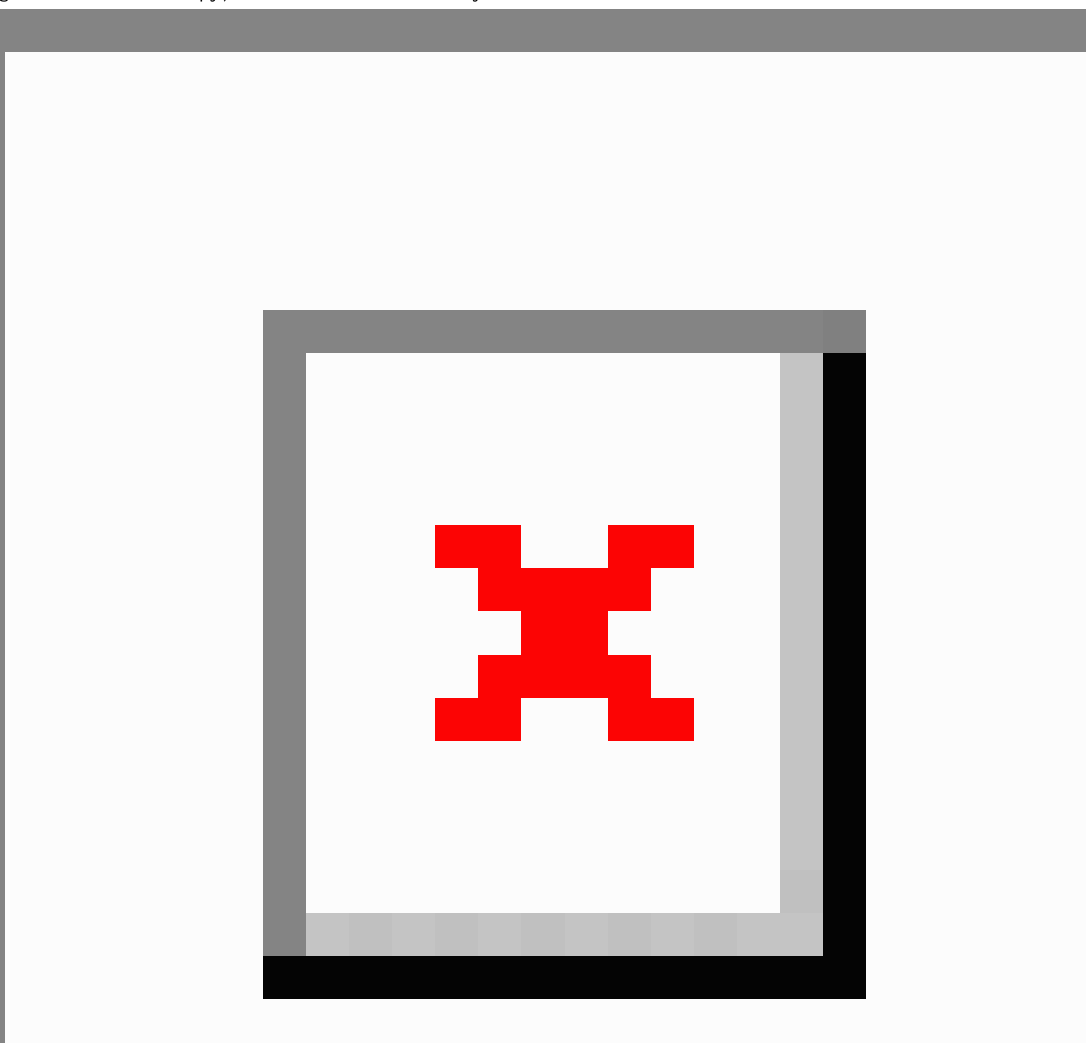
Figure 2. Mean Generalized Anxiety Disorder-7 (GAD-7) scores at all assessments for both conditions. ACT: acceptance and commitment therapy; CBT: cognitive behavioral therapy; GAD-7: Generalized Anxiety